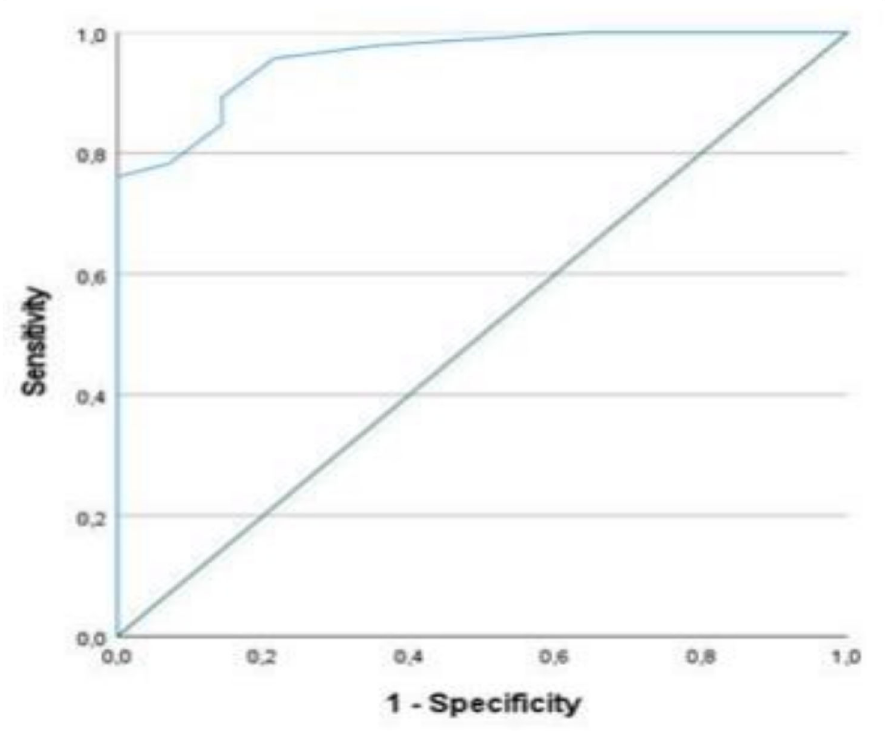
Figure 4. Area under the receiver-operating characteristic curve (AUC-ROC) method plotting the true-positive rate as a function of the false-positive rate for a cutoff point of sPAP with respect to a 0.26 ratio of sPAP/PAAT, as the threshold value, showed 0.957 AUC-ROC value ( p =